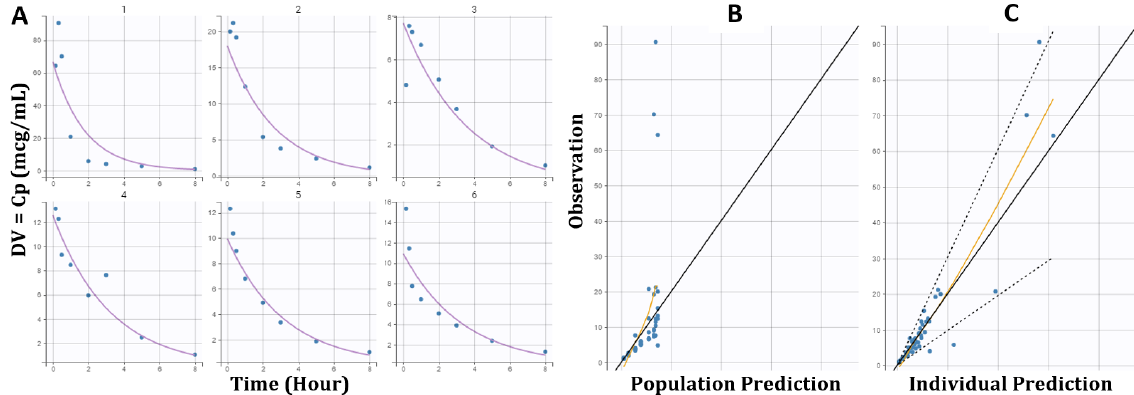
Figure 1. The goodness of fit of the one-compartment open model of levofloxacin after intravenous bolus injection, i.e., individual data fitting analyses (panel A); observation versus population prediction analysis (panel B) and observation versus individual prediction analysis (panel C).